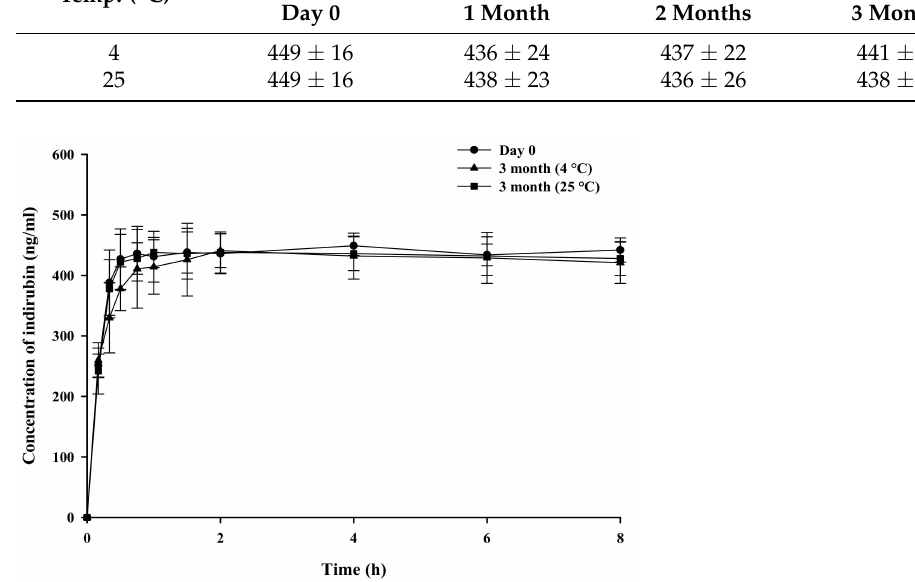
Figure 7. Solubility of indirubin in SD-F4 after three months of storage at 4 ◦ C and 25 ◦ C (mean ± s.d., n = 3). Table 2. Dissolution of indirubin from SD-F4 after storage at 4 ◦ C and 25 ◦ C (mean ± s.d., n = 3). Temp. ( ◦ C)